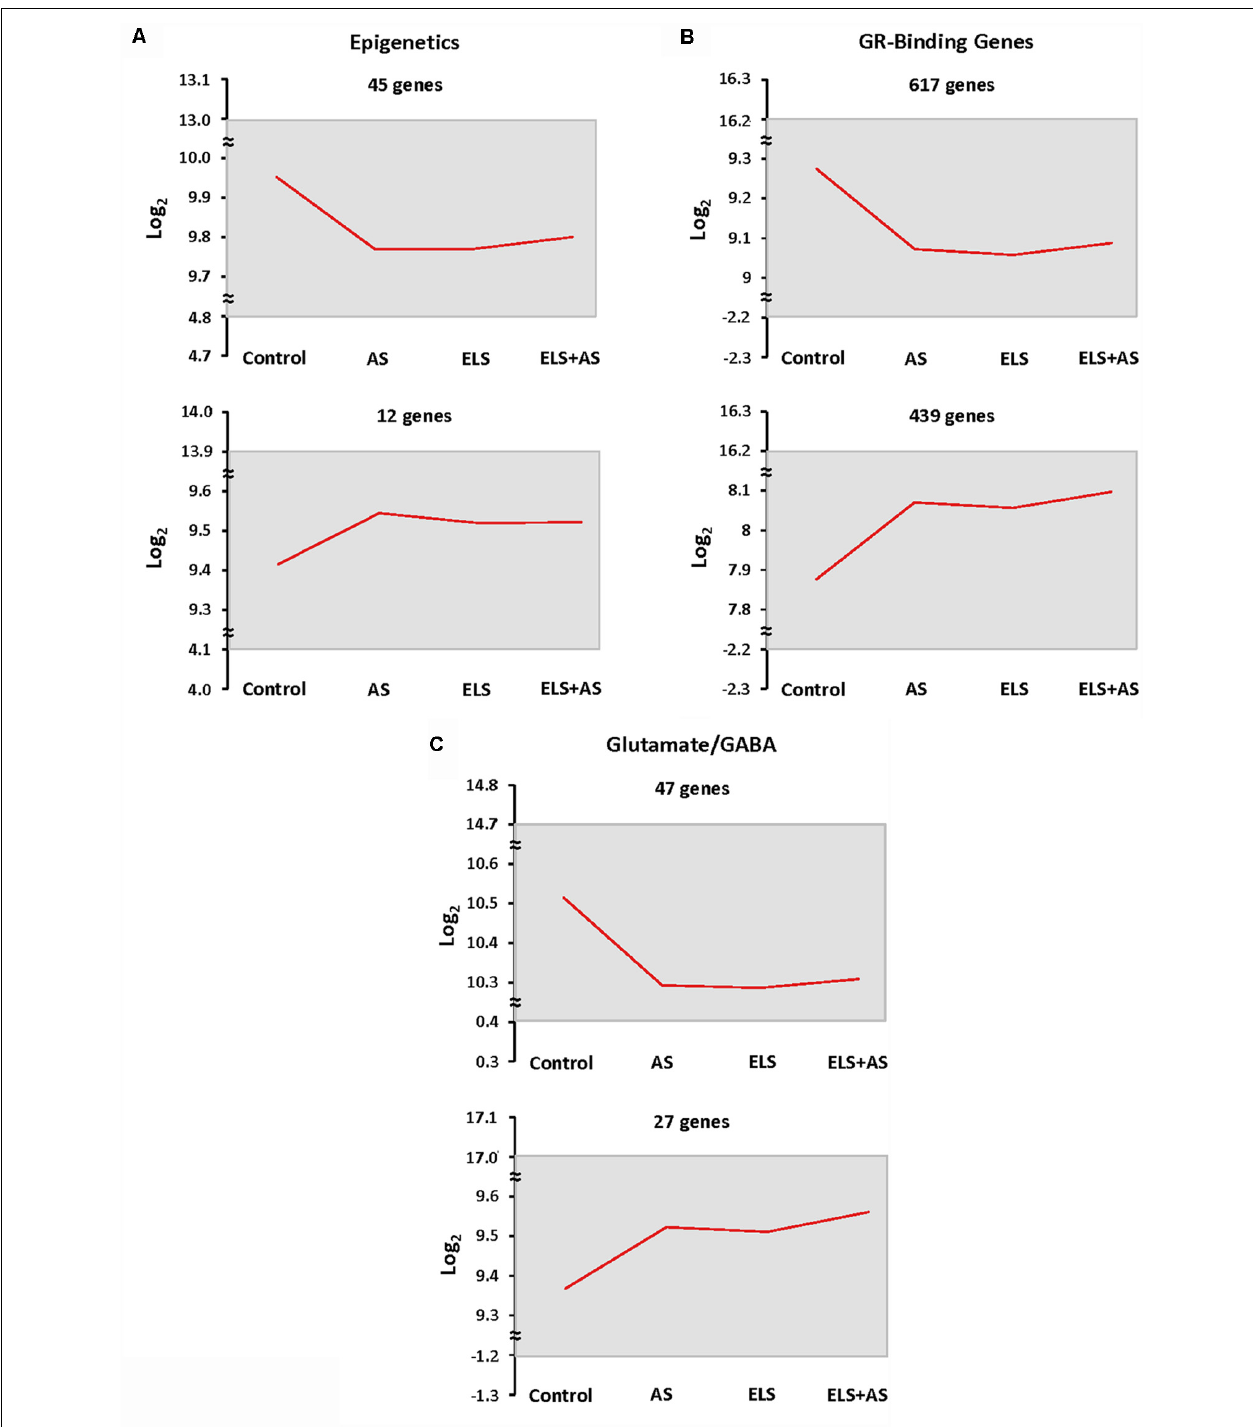
FIGURE 4 | Epigenetic profiling of ELS mice shows a stressed state in the absence of AS. (A–C) Clustering of epigenetic, GR-binding, and glutamate/GABA genes by expression profiles shows that many genes are downregulated in every experimental group when compared to unstressed control mice. Genes were clustered based on the log2 transformation of counts in control mice subjected to AS, ELS mice, and ELS mice subjected to AS vs. unstressed control mice. The mean of the log2 transformation of counts is presented as a red line graph with the maximum and minimum values of the cluster represented as a gray rectangle. The top two most populated expression patterns are shown. ELS: mice with a history of early life stress. AS: control mice subjected to acute stress. ELS + AS: ELS mice subjected to acute stress.